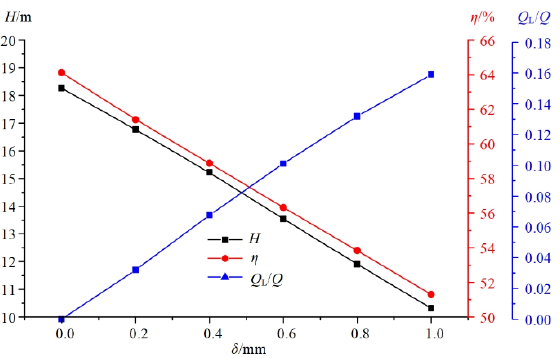
Figure 6. Influence of tip clearance size on the leakage flow rate and energy performance.